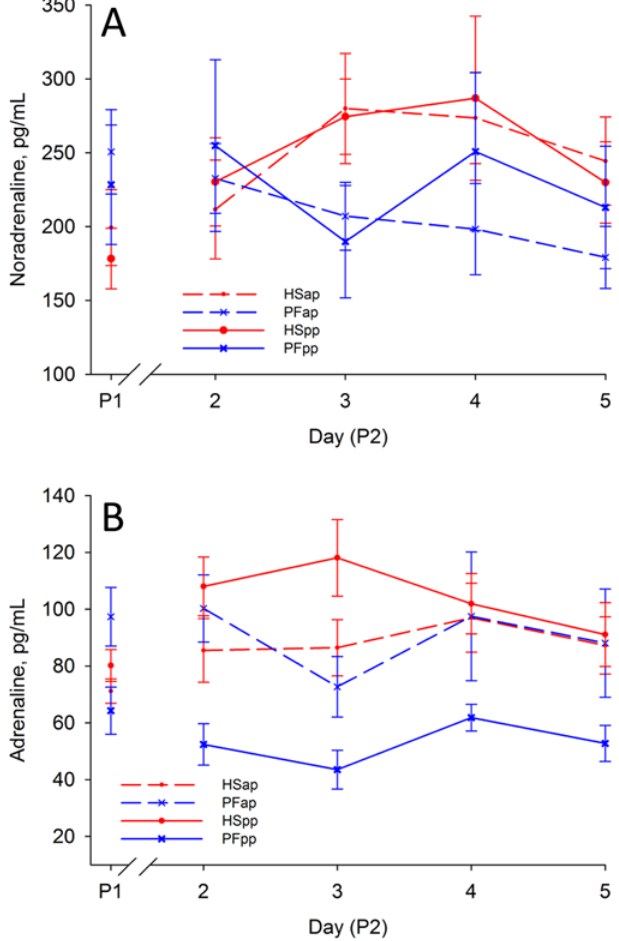
Fig 6. Catecholamines. Effect of heat stress (HS) and pair-feeding (PF) on (A) plasma noradrenaline and (B) adrenaline. In experimental period 1 (P1) all animals were kept at thermoneutral conditions (THI = 59.7) with ad-libitum feeding for six days. During period 2 (P2), HS cows (red lines) were heat-stressed (THI = 76.1), whereas PF cows (blue lines) were pair-fed in thermoneutrality (THI = 60.0) for six days, once ante partum (ap, dashed lines) and again post-partum (pp, solid lines). All data given as mean ± SEM; for P1 the mean of the last days of period 1 is given as used for baseline correction. Numbers of animals analyzed per group: HSap n = 7, PFap n = 6, HSpp n = 6, PFpp n =